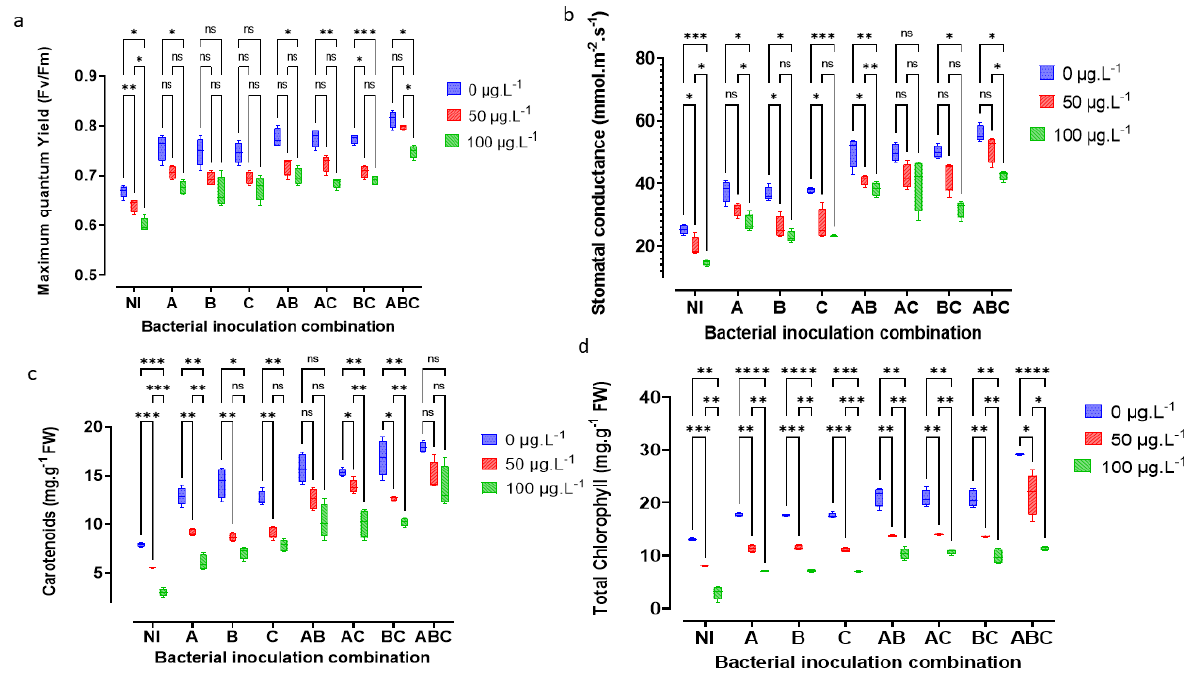
Figure 3. Detrimental impact of MC and beneficial effect of bacterial addition on the maximum quantum yield, MQY, in Fv/Fm ( a ); stomatal conductance, gs, in mmol m − 2 s −1 ( b ); Carotenoids, Car, in mg g −1 fresh weight ( c ); and total chlorophyll (a + b), TChl, in mg g −1 fresh weight ( d ). The letters NI correspond to the sterile control without bacteria. A = SLB1 is the strain isolated from Microcystis - bloom, B = SLB3 is the strain isolated in MC — contaminated water, and C = RTC10 is the strain isolated in agricultural MC contaminated with MC soil. The stars correspond to statistical signifi- cance at different levels as ns= not significant; * = p < 0.05; ** = p < 0.01; *** = p < 0.001; **** = p < 0.0001. A post hoc comparison at the 5% threshold using the Benjamini – Hochberg false dis- covery rate correction for MC shows that all pairwise groups are highly significant, p < 0.05. For bacterial addition, highly significant differences were noted between groups dif- fering in terms of addition level. Treatments with the same level of bacterial addition — one strain (A with B or C) or two strains (A × B with A × C or B × C) — were not significantly different . In the sterile control, the concentration of 100 μg MC/L conferred decreases of 10.45% MQY, 77.28% TChl, 41.73% gs, and% 61.64 Car. On the other hand, when compar- ing 0 and 100 μg MC/L , the triple bacterial addition with SLB1, SLB2, and RTC10 resulted in increases of 20.9% and 11.94% for MQY; an increase of 123.41% and a decrease of 12.97% TChl compared to a decrease of 77.28% in the sterile control; increases of 121.22% and 68.82% gs; and increases of 125.66% and 72.83% Car, respectively.